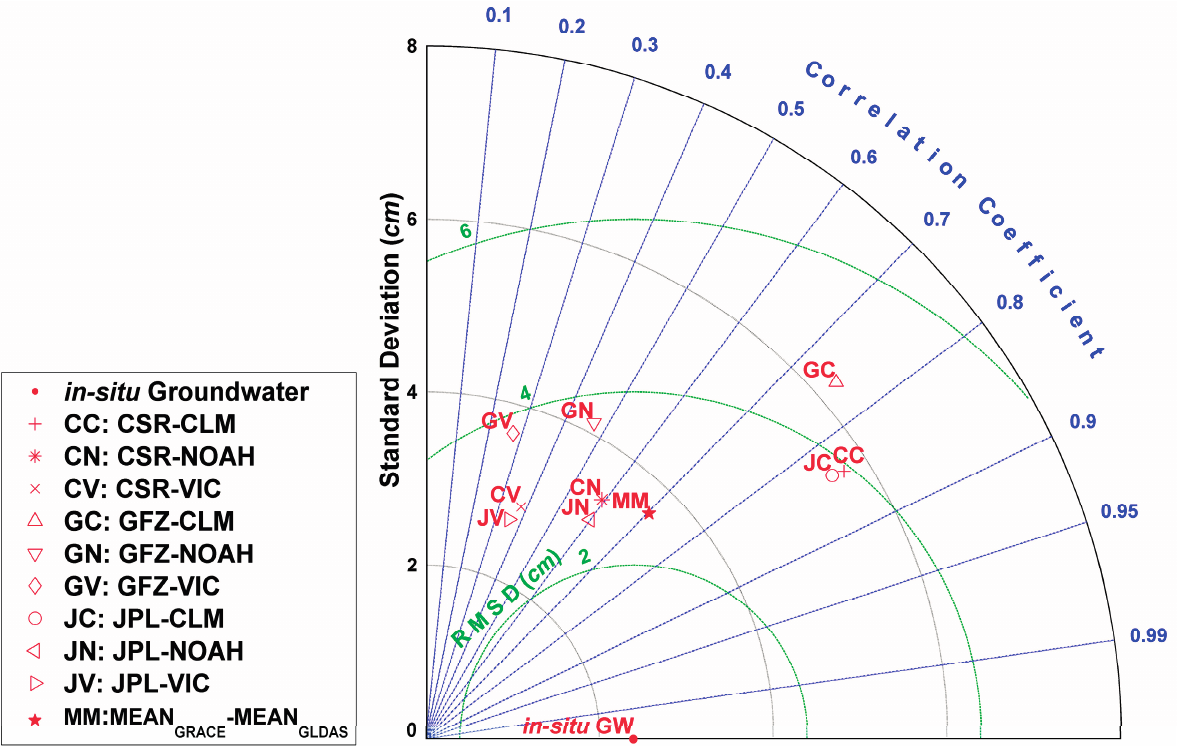
Figure 4. Taylor diagram displaying the pattern of the statistics between GRACE-GLDAS based (from different institutions and land surface models) and in-situ groundwater